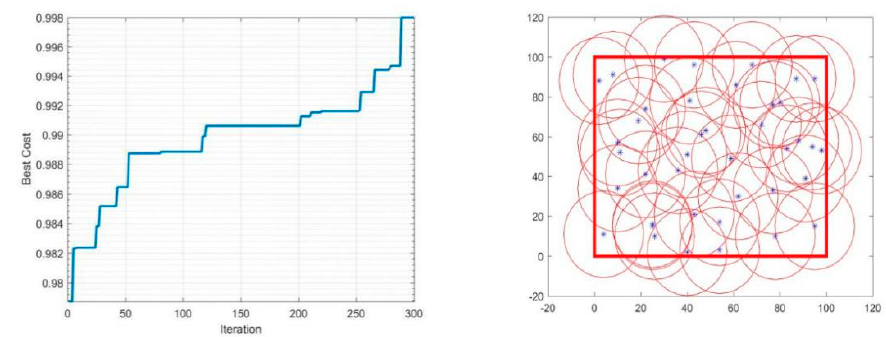
Figure 6. Coverage of 40 sensors.